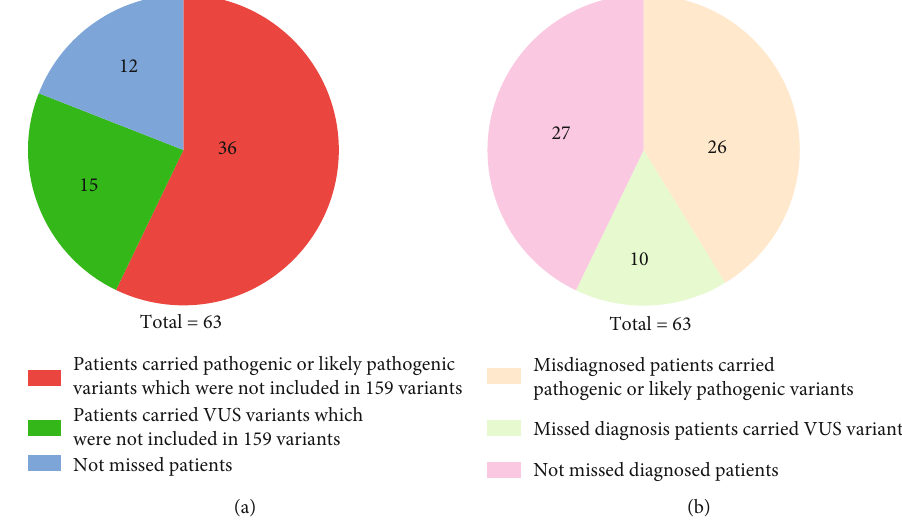
Figure 1: Analyze the genetic etiology of patients who received 127 gene panel testing compared with 159 variants. (a) 36 patients carried pathogenic or likely pathogenic variants which were not included in 159 variants, fi fteen patients carried VUS variants which were not included in 159 variants, and 12 patients do not carry the variants which were not included in 159 variants. (b) 26 patients who carried pathogenic or likely pathogenic variants would misdiagnose if they were only detected by 159 variant testing, ten patients who carried VUS might miss diagnosis, and twenty-seven patients would not miss